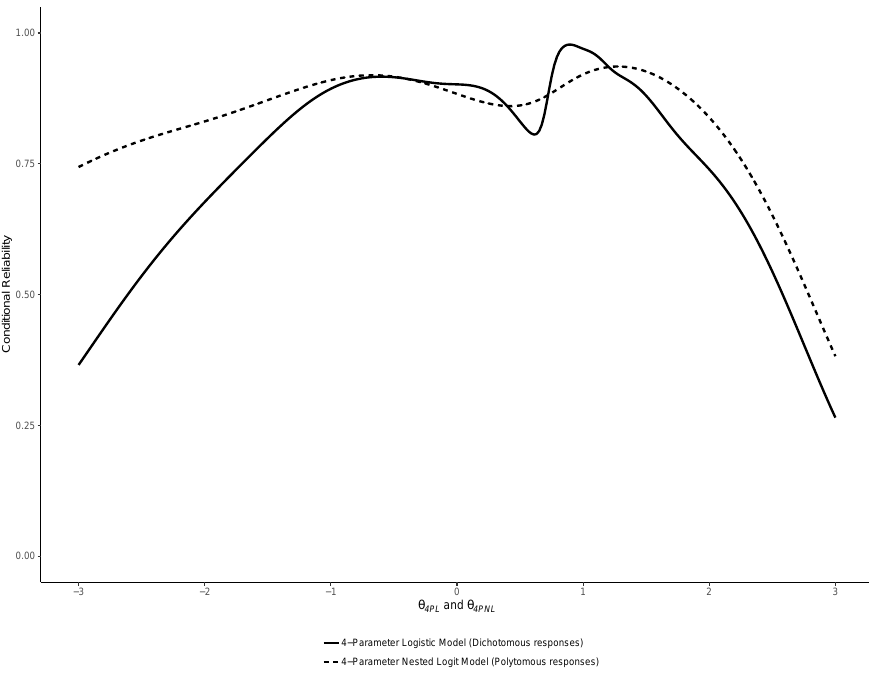
Figure 10. Comparison of the reliability functions of the 4-Parameter Logistic (4PL) and Nested Logit (4PNL)